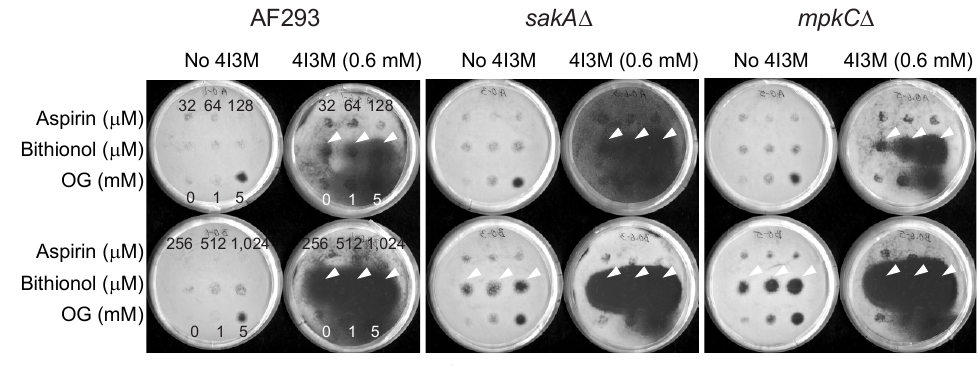
Figure 3. Enhancement of antifungal activity of bithionol by 4I3M tested in A. fumigatus . 4I3M, 4-isopropyl-3-methylphenol; OG, octyl gallate (positive control).